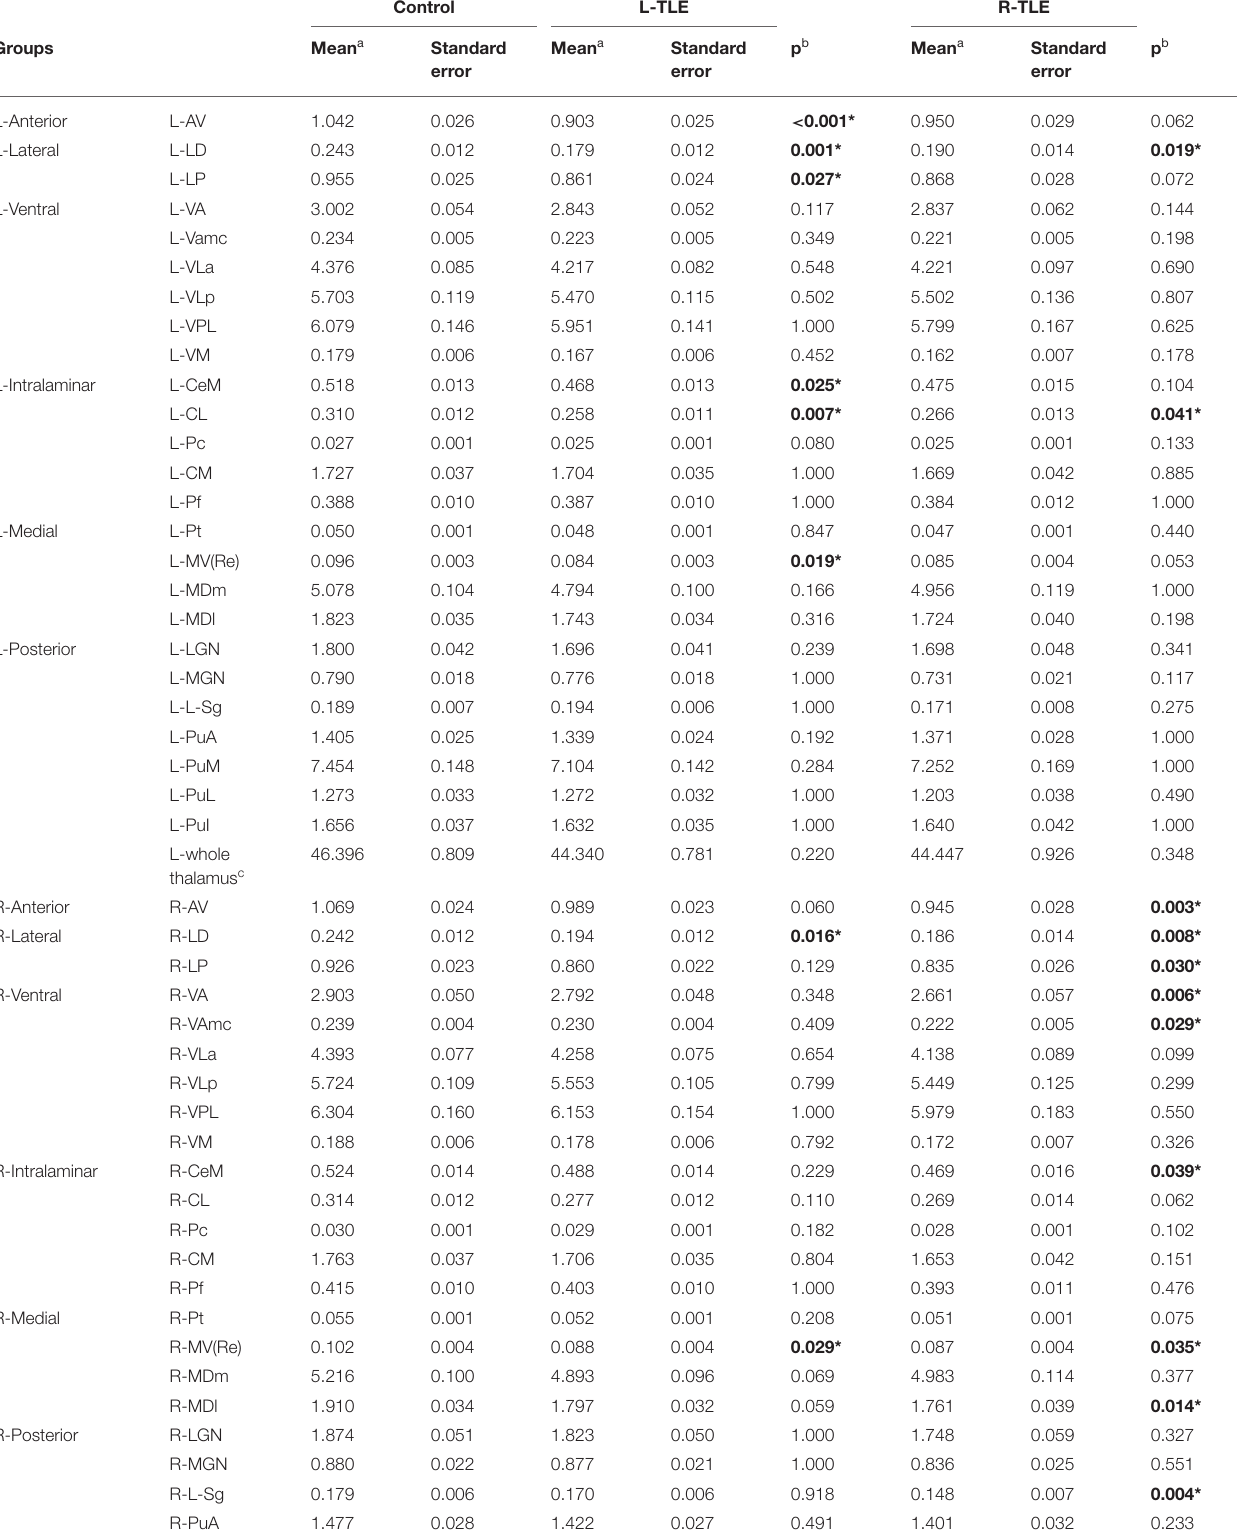
TABLE 2 | The volume of each thalamic nuclei in the two pharmaco-resistant epilepsy groups and the controls.